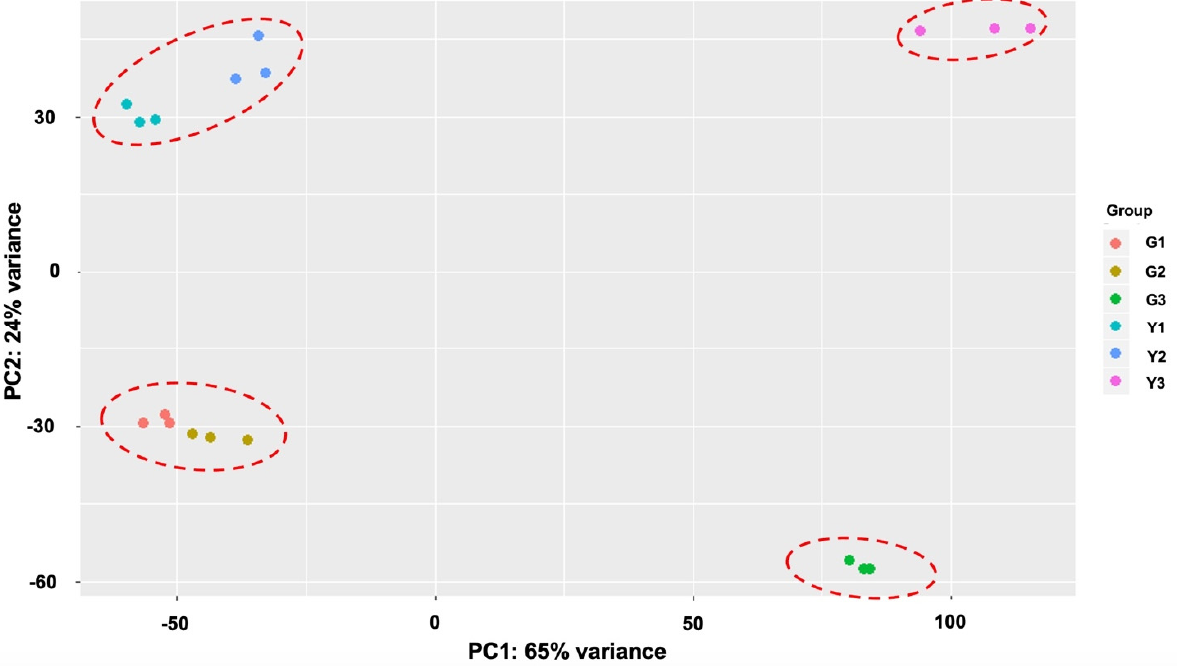
Figure 4. PCA biplot showing transcriptome clusters of the developmental stages of the different stigmas of MR-1 and M4-7.